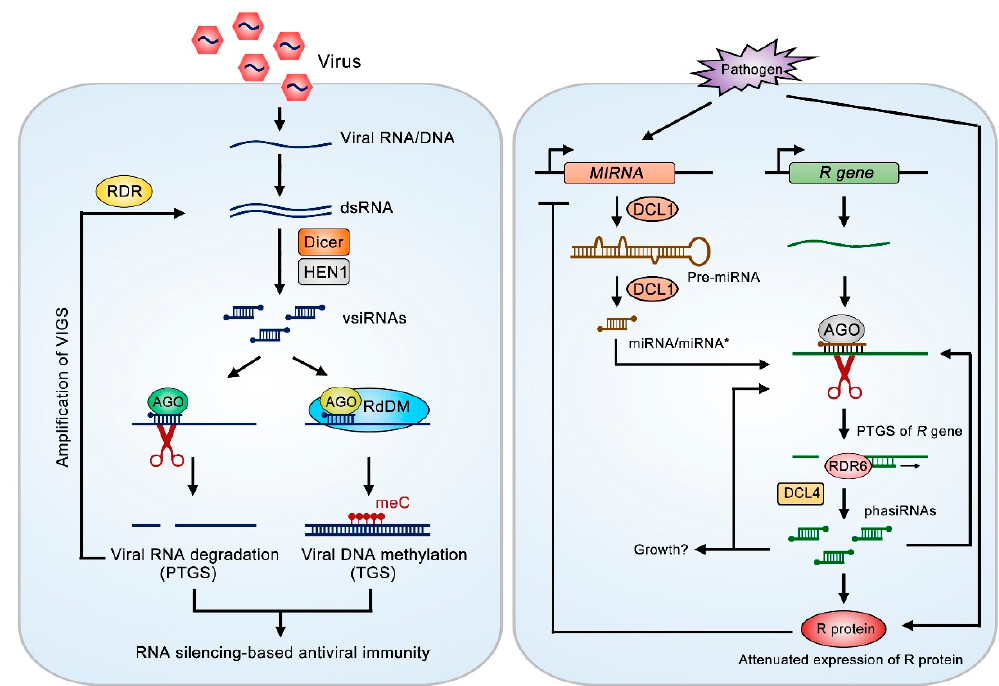
Figure 1. RNA silencing-based immunity and its cross-talk with R gene-mediated immunity. Left panel: RNA silencing-based immunity. Replication of viral RNA triggers the synthesis of dsRNAs, which are then processed by Dicer RNase into 21–24 nt siRNAs. Some 21–22 nt vsiRNAs are loaded onto Argonaute-RNA-induced silencing complex (AGO-RISC) complex (such as AGO1 in Arabidopsis) to mediate sequence-specific degradation of viral RNAs (PTGS). Virus-induced gene silencing (VIGS) can be amplified by RDR-dependent formation of dsRNA from the cleaved target mRNA. 24 nt vsiRNAs are loaded onto AGO-RdDM silencing complex to target viral DNA for DNA methylation modification, thereby leading to silencing of viral genes at TGS level. Some pathogens are capable of interfering with miRNA biogenesis to facilitate infection. Right panel: In plants, miRNA is firstly transcribed from MIRNA gene by pol II and processed into pre-miRNA, the stem loop precursor, and then processed into miRNA / miRNA* duplex by DCL1. Mature miRNA is loaded into AGO-RISC complex to trigger degradation of R gene mRNA, leading to attenuated expression of R protein. Some R gene-targeting miRNAs is capable of triggering the production of RDR6 and DCL3-dependent phased secondary siRNA (phasiRNAs) from the cleavage site of R gene mRNA. The R gene-derived phasiRNA can induce trans-acting silencing of R gene or other target genes (such as growth-related gene). In addition, perception of pathogen infection will activate the expression of R genes, and R protein can also exert a negative regulation on the expression of MIRNA